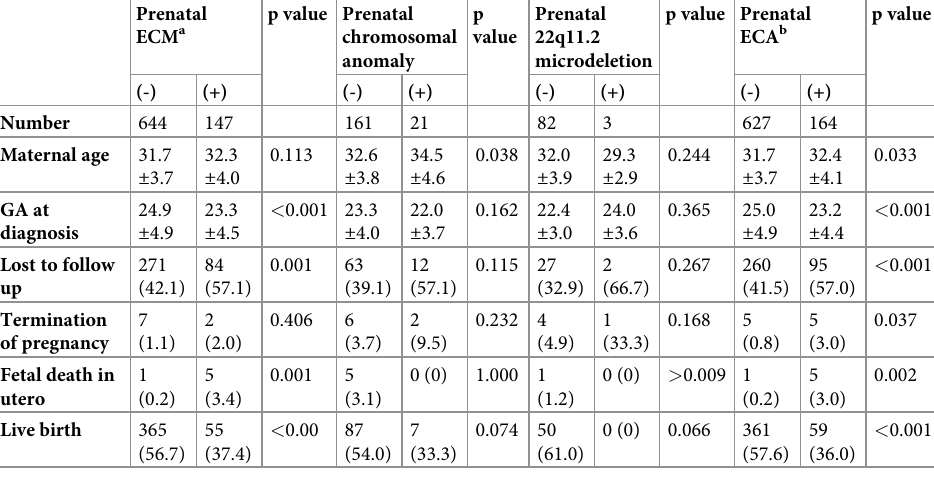
Data are shown in number (%) or mean ± standard deviation. ECM, extracardiac malformations; ECA, extracardiac anomalies; GA, gestational age. a extracardiac malformations defined as extracardiac structural malformation. b